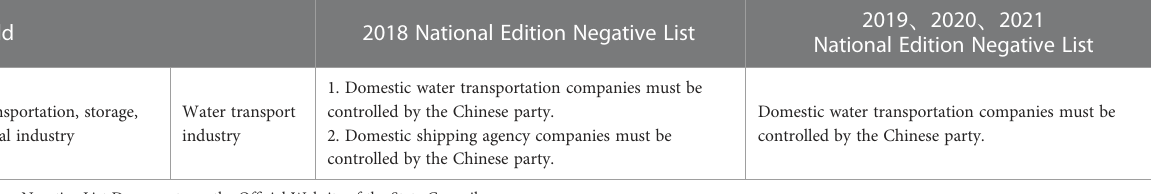
TABLE 2 Negative list of foreign investment access in the shipping fi eld (National edition: 2018-2021).